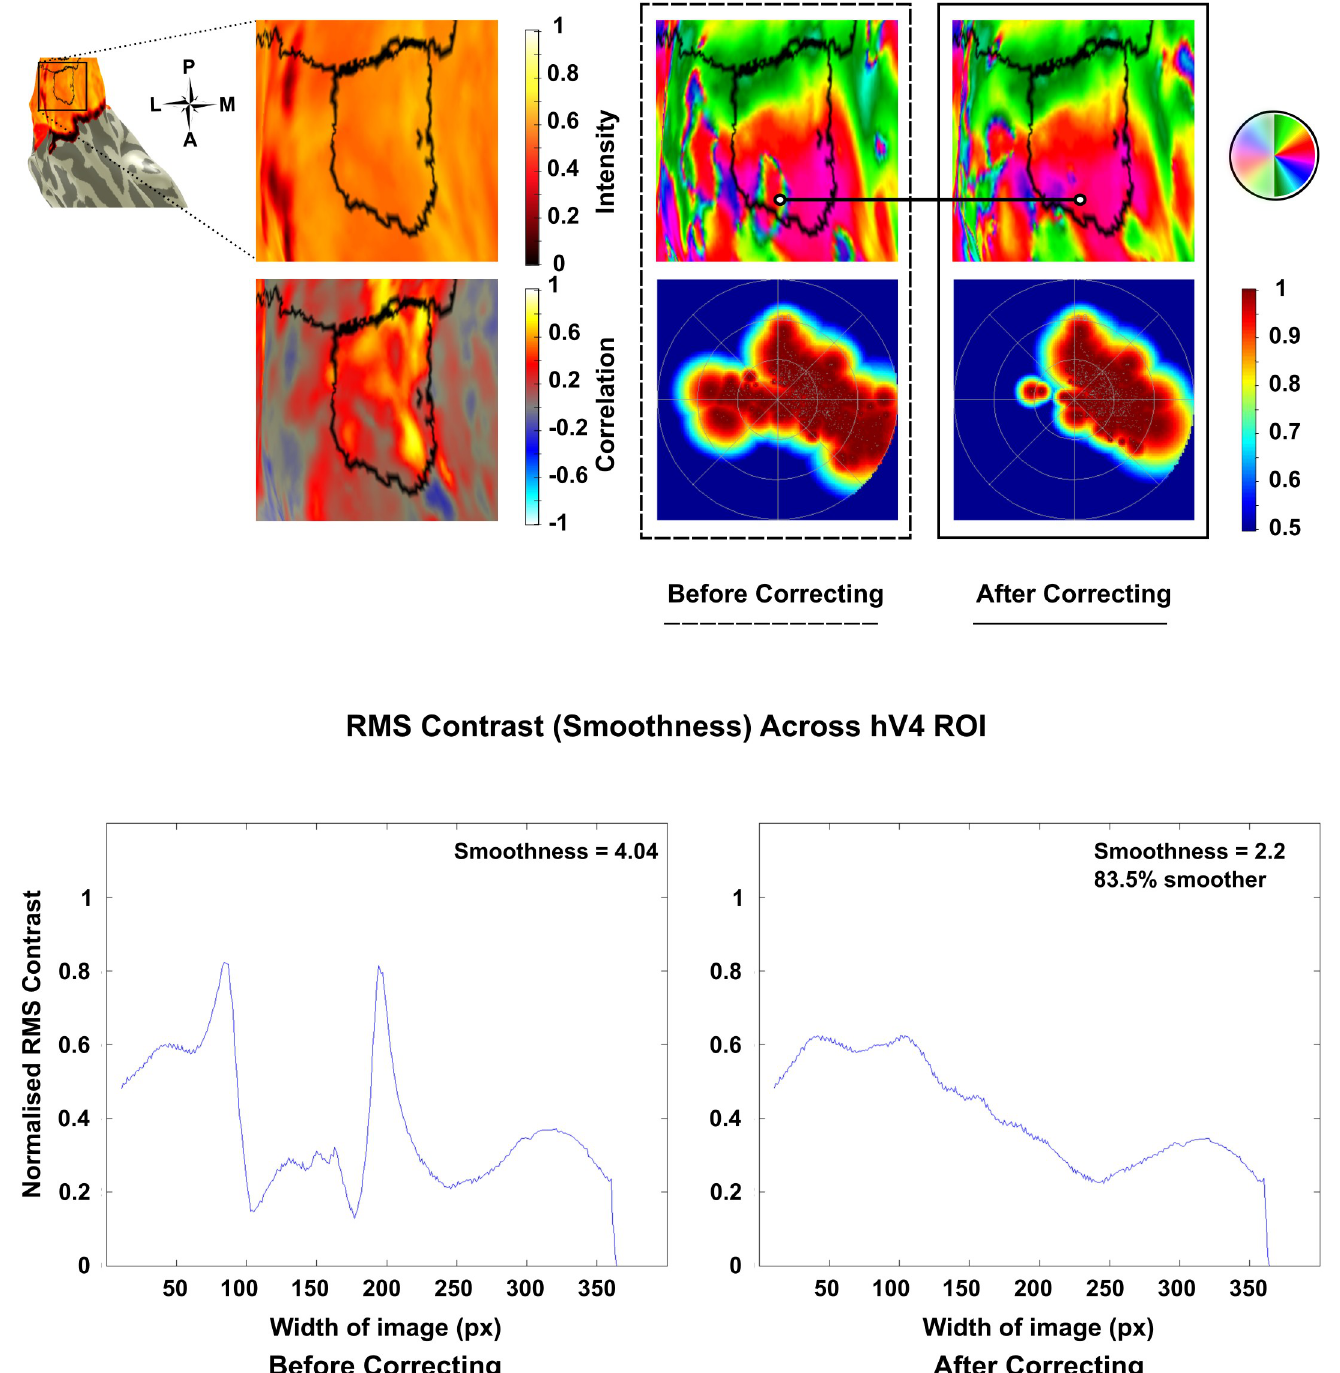
Fig 6. Improvements in the left hemisphere hV4 map of Subject 6 were noted post correction of inverted voxels. Initially a disturbed polar angle map was recorded along the lower boundary, which was restored after flipping inverted voxels. The normalised pRF denisty plot for the corrected map shows fewer voxels appearing to respond to the ipsilateral hemifield and the corrected map is 83.5% smoother, though still incomplete.